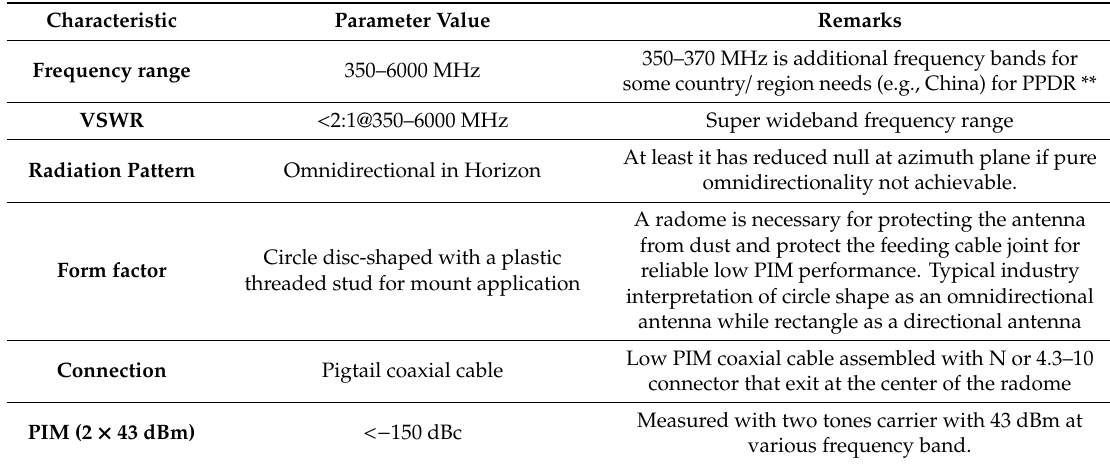
Table 3. The summary of the ULP ceiling mount antenna requirement that enables PS \ PPDR (UHF 350 MHz Band) and cellular DAS application.